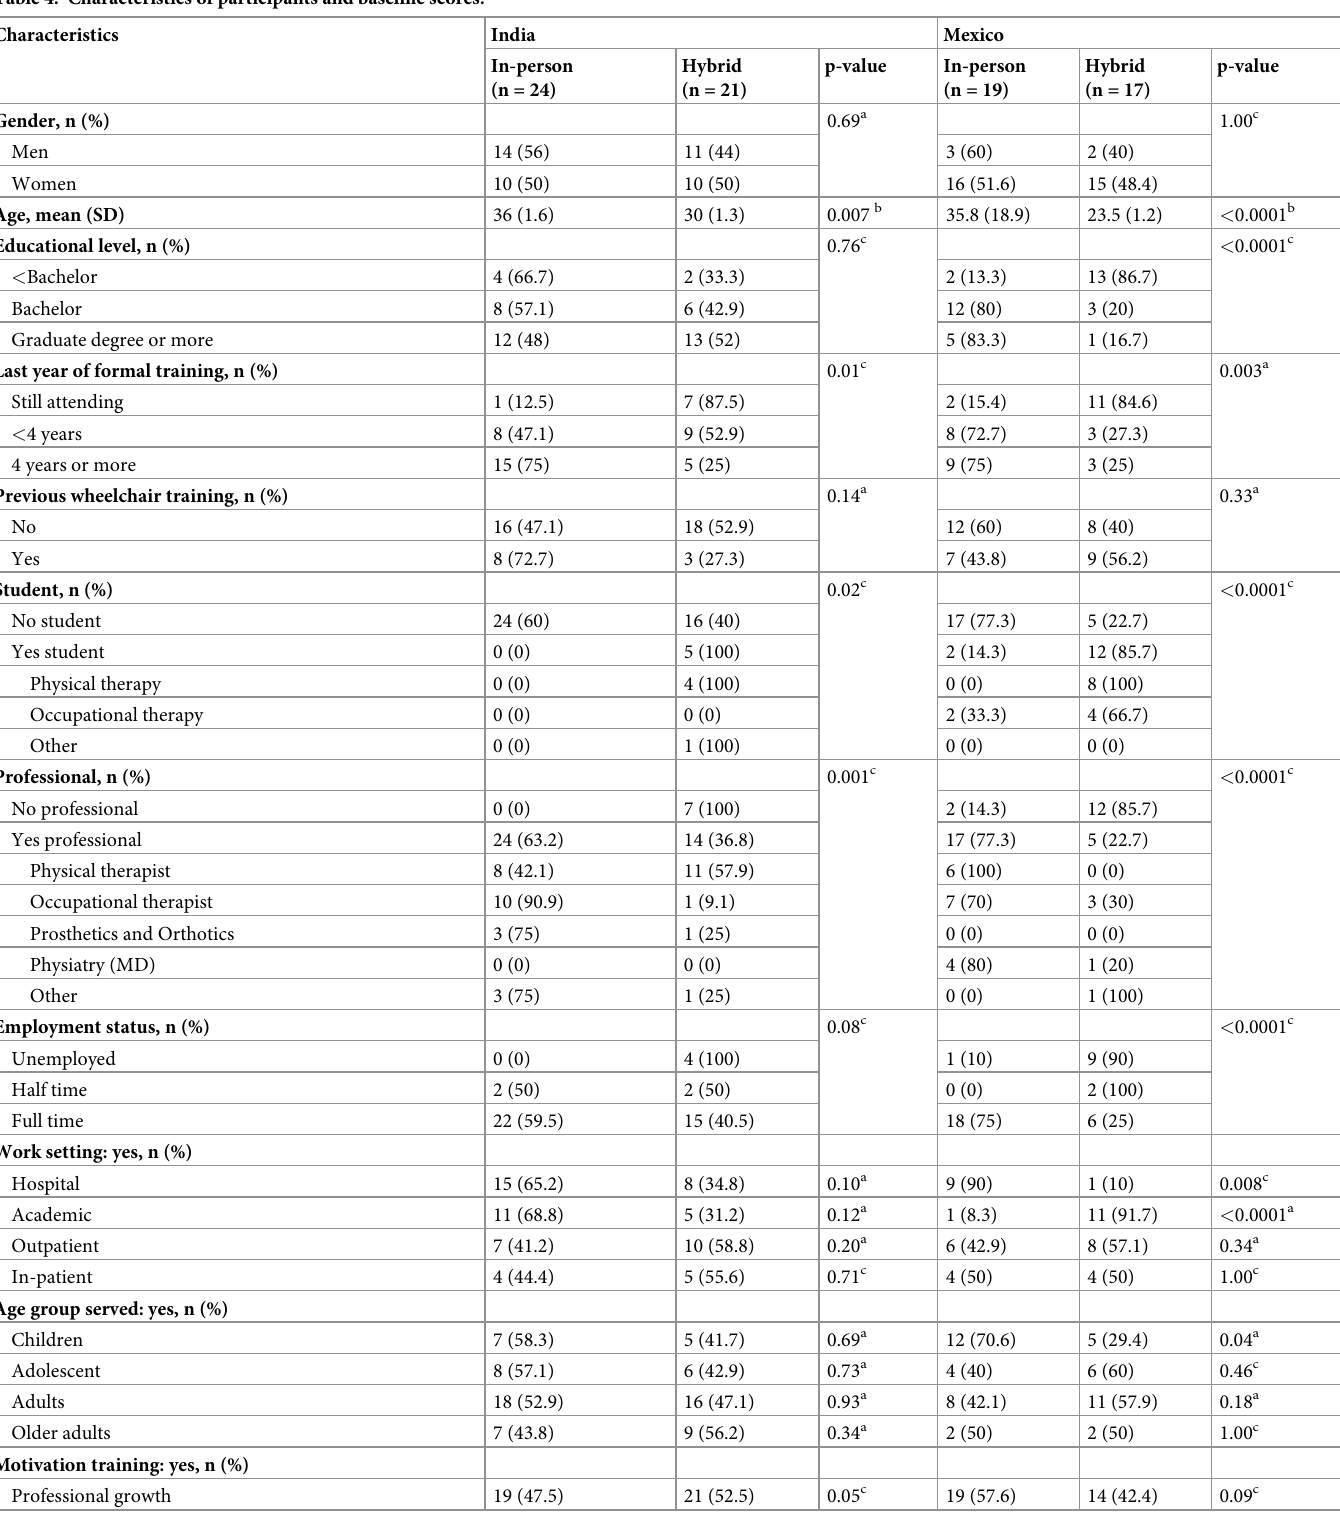
Table 4. Characteristics of participants and baseline